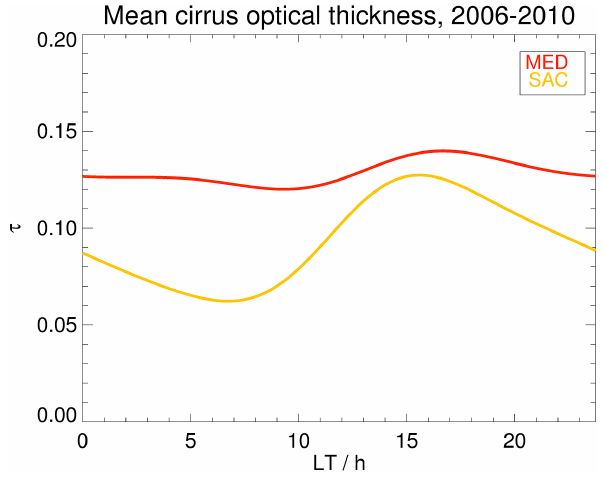
Figure 11. Mean cirrus coverage for the year 2010 at a resolution of 0.5 ◦ × 0.5 ◦ derived by COCS with the southern Africa region (SAC, orange box) and the Mediterranean region (MED, red box).